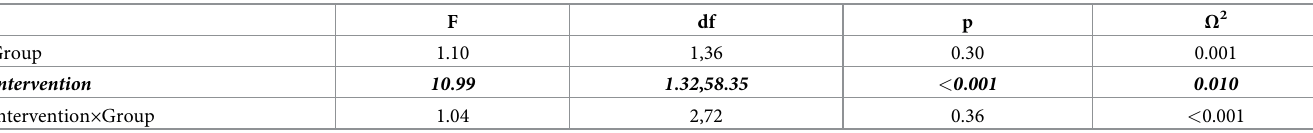
Table 1. ANOVA results of HR.